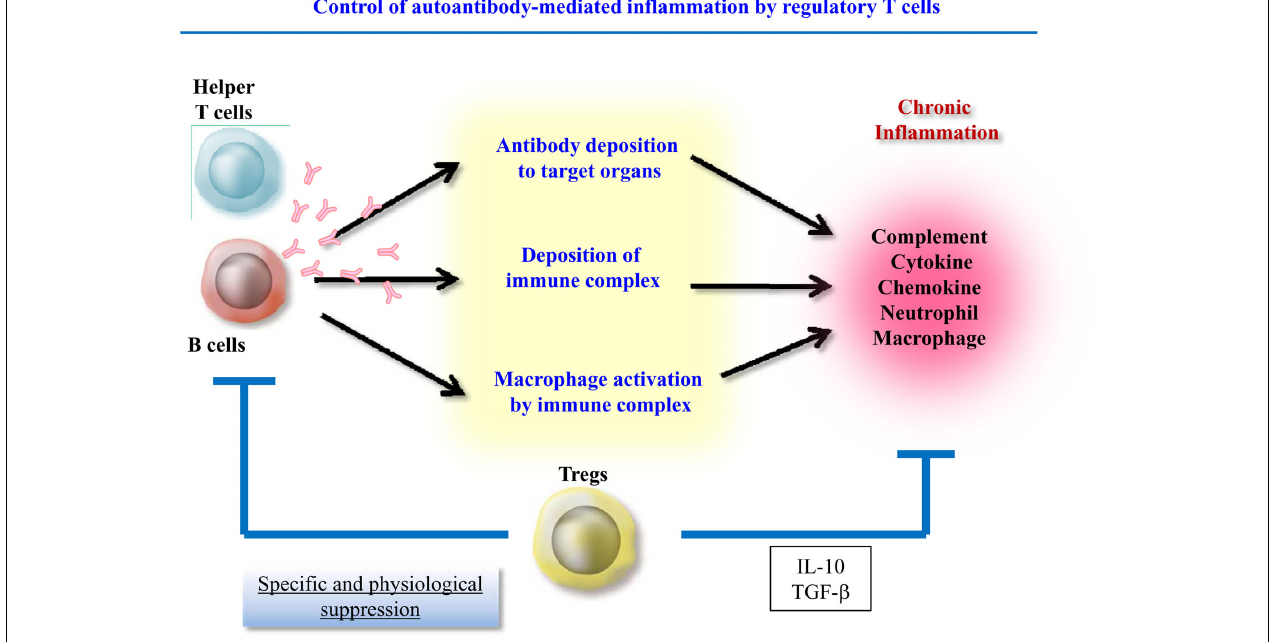
FIGURE 1 | Control of autoantibody-induced inflammation by regulatoryT